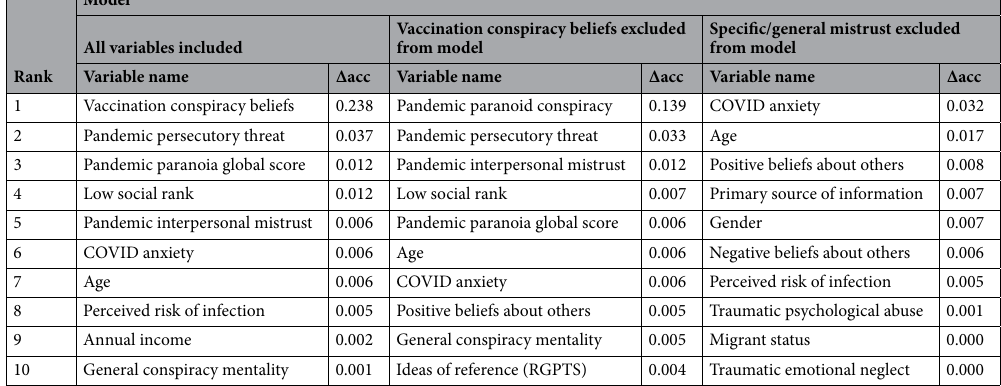
Table 5. Variable importance for the ten highest ranking variables across each model based permutation feature importance. Δacc values indicate the mean decrease in accuracy over ten permutations of the respective variable.